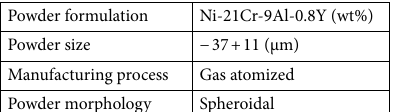
Table 1. The composition and characteristics of the Amdry 9624 MCrAlY